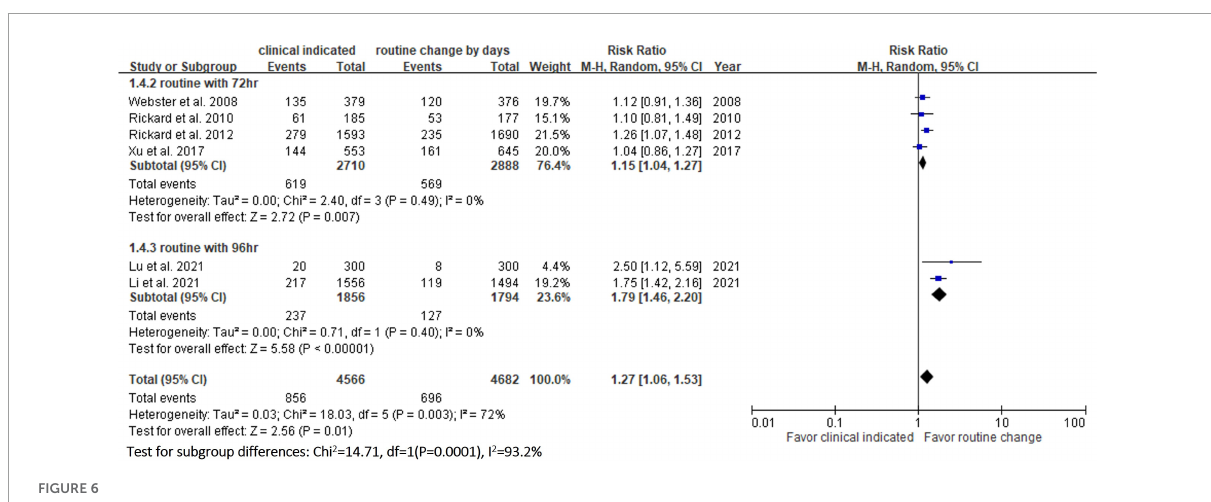
FIGURE6 Forest plot of the risk of local